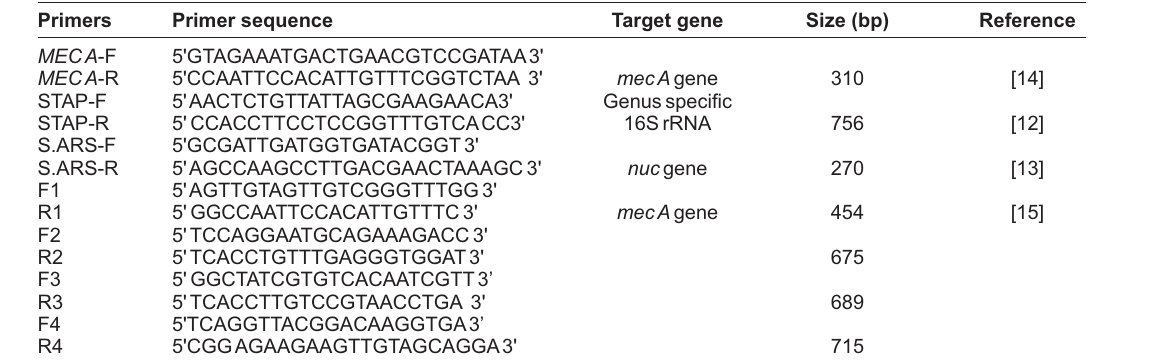
Table-2: Oligonucleotide primer sequence used for amplification of the following target gene in this